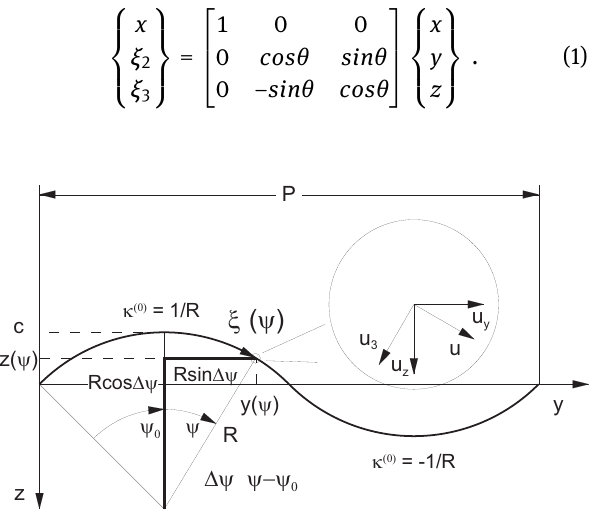
Figure 2: Unit-cell geometry and coordinate conventions